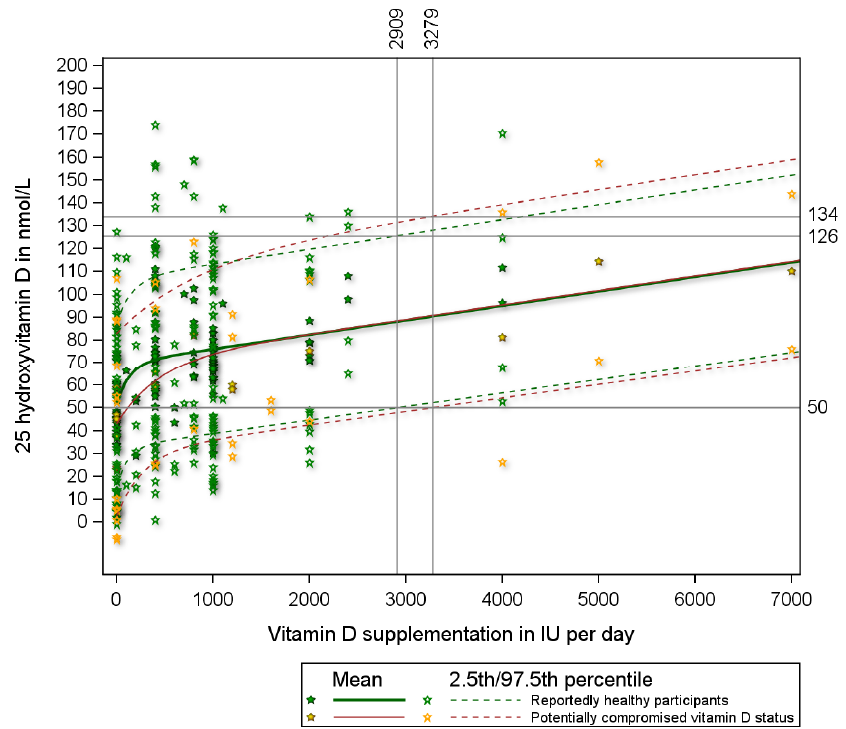
Figure 1. The mean and 95% prediction interval (2.5th and 97.5th percentiles) of serum 25(OH)D concentrations by vitamin D supplementation derived from published study means and standard deviations. Note: The 2.5 percentile line depicts 25(OH)D concentrations for any given vitamin D supplementation dose with 2.5% of all expected 25(OH)D responses to have values below the line, and 97.5% to have values above the line. The 97.5 percentile line depicts 25(OH)D concentrations for any given vitamin D supplementation dose with 97.5% of all expected 25(OH)D responses to have values below the line, and 2.5% to have values above the line. The area between the 2.5 percentile line and the 97.5 percentile line depicts the 95% prediction interval of 25(OH)D concentrations for any given vitamin D supplementation dose. The equation for the mean response for reportedly healthy individuals is Y = 51.9 + 17.7 *(1 − e − 7.4*X ) + 6.3 *X in which Y denotes serum 25(OH)D (in nmol/L) and X vitamin D supplementation (in 1000